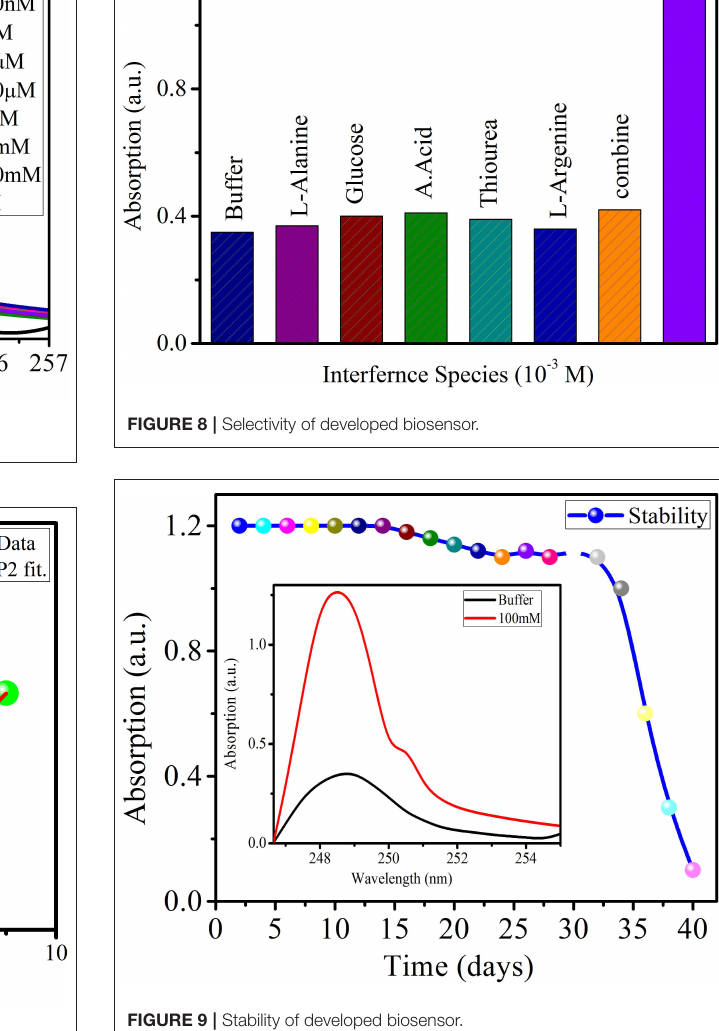
FIGURE 7 | Experimental data fitting.